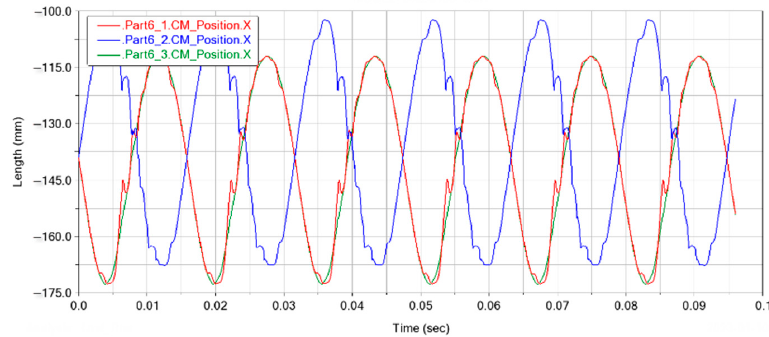
Figure 12. Engine piston displacement curve.